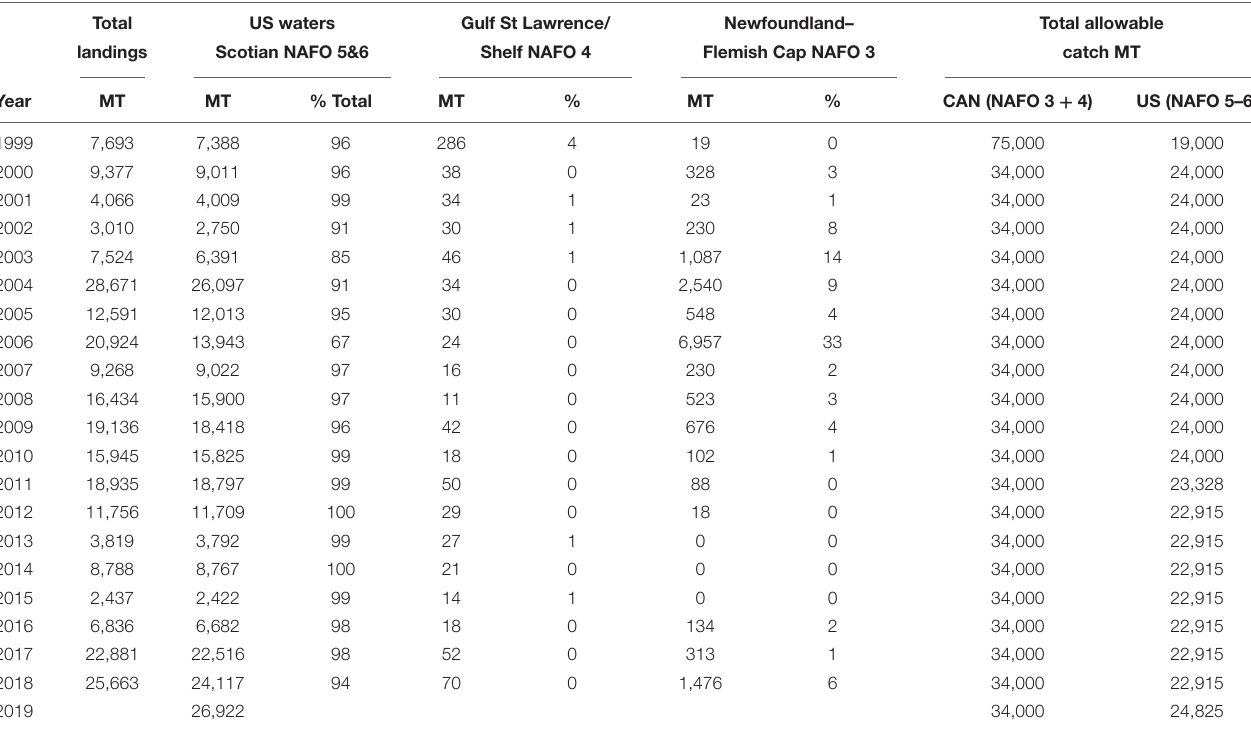
TABLE 3 | Shortfin squid landings (in metric tons, MT) and percent of total landings in US (NAFO 5&6), and Canadian waters (NAFO 3&4) since 1999 when Canadians ceased licensing foreign fishing on the Nova Scotia Shelf.